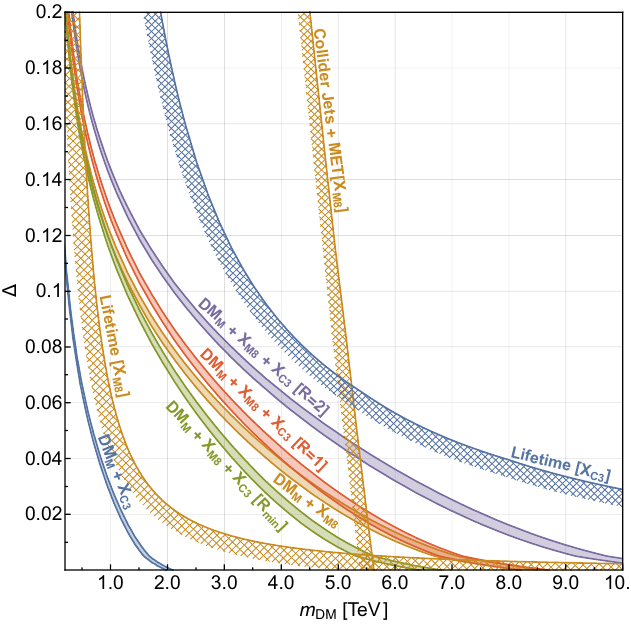
Figure 11 . Example model for colored coannihilation which shows the general interplay among collider limits and relic abundance constraints. We compare two models with either a single X C3 (blue) or a single X M8 (orange) coannihilation partner to a model with both X C3 and X M8 at the same time. We show three scenarios for the two partner model: one where the mixed annihilation is absent (green) and two other scenarios with R = 1 (red) and R = 2 (purple). Imposed are the exclusion limits from a prospected 100 TeV hadron collider for the single partner